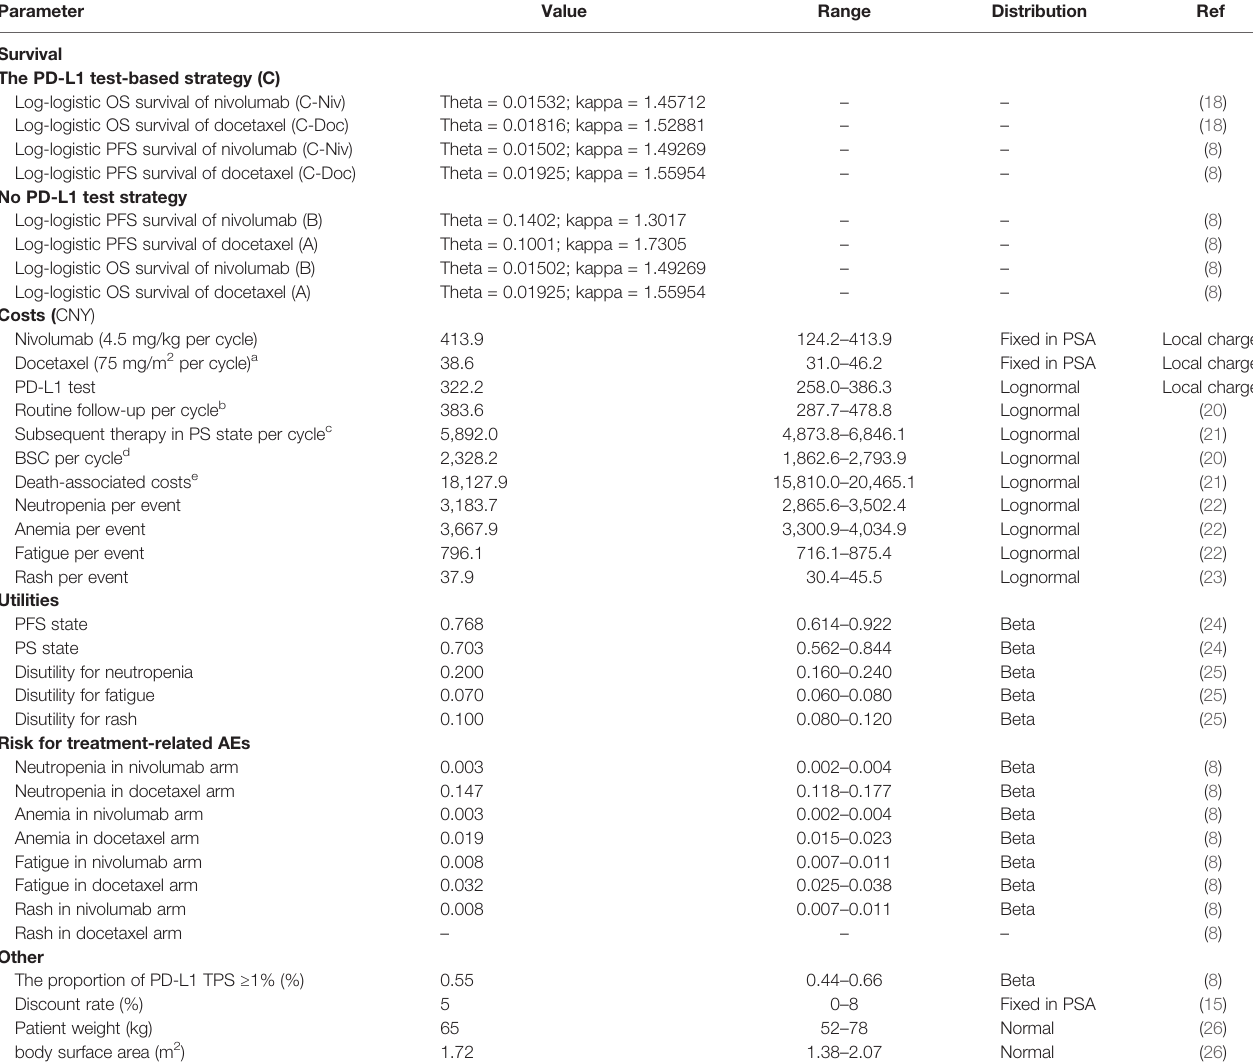
TABLE 1 | Model parameters: baseline values, ranges, and distributions for sensitivity